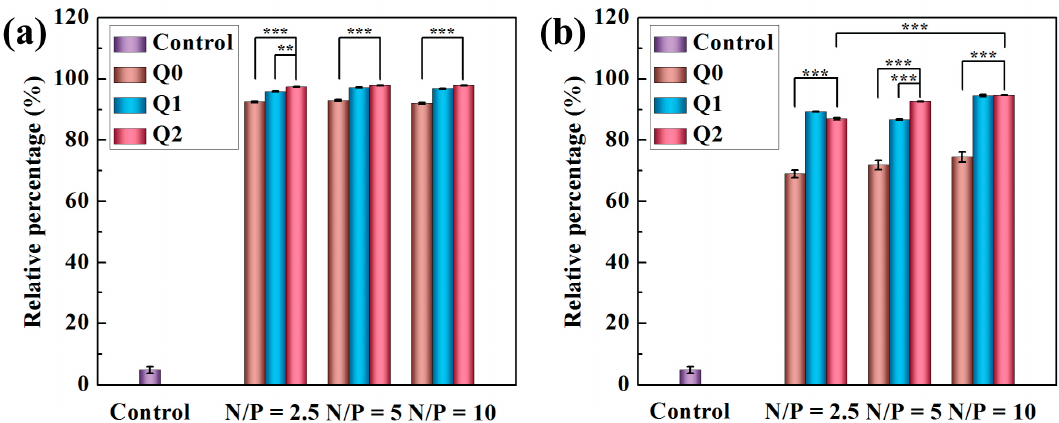
Figure 5. Flow cytometry analysis of U87MG cells transfected using vector/Cy3-Bcl-2 siRNA ( a ) and vector/Cy3-VEGF siRNA ( b ) polyplexes at the N/P ratios of 2.5:1, 5:1, and 10:1, respectively. Cells without treatment were used as control. Data are shown with mean ± SD ( n = 3). For ( a , b ), ** and *** mean that the p values of statistical analyses are < 0.01 and < 0.001, respectively.